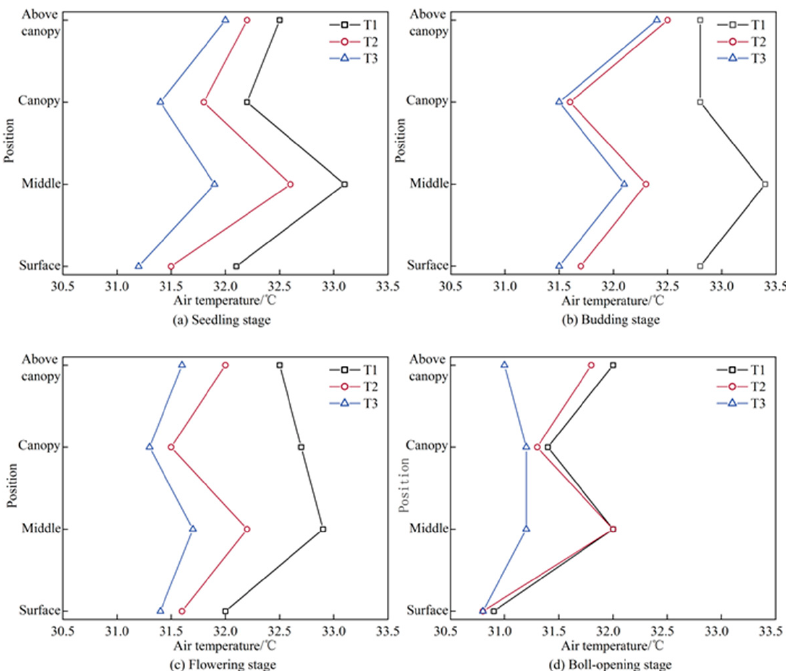
Figure 4. The air temperature changes at different growth stages and locations under different irrigation methods: ( a ) is the variation of seeding stage; ( b ) is the variation of budding stage; ( c ) is the variation of flowering stage; ( d ) is the variation of Boll-opening stage.